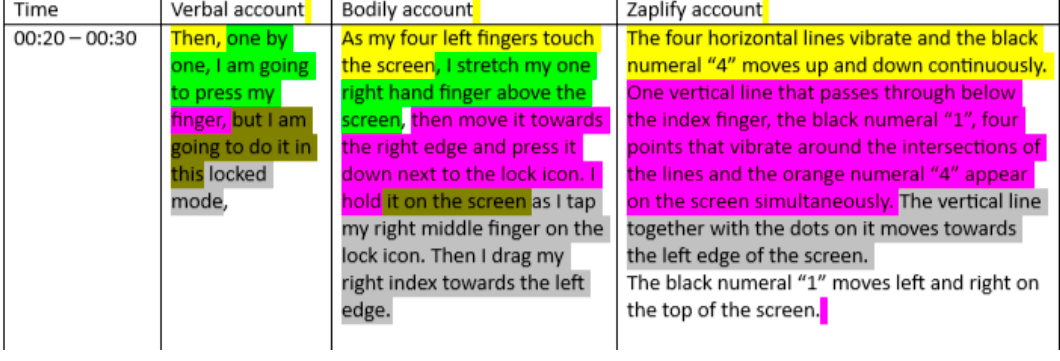
( c ) Figure 10. ( a – c ) The three steps of drawing an M-ple.